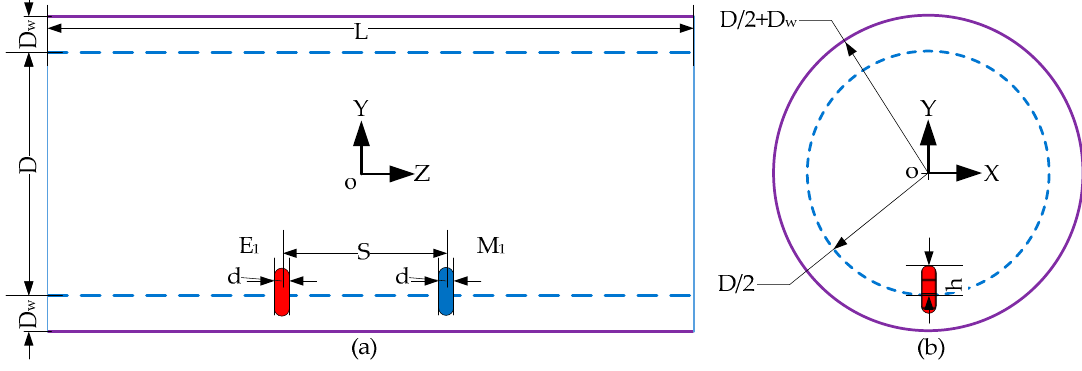
Figure 1. The geometric structure and the parameters of the MCP: ( a ) the axial section; ( b ) the cross section.